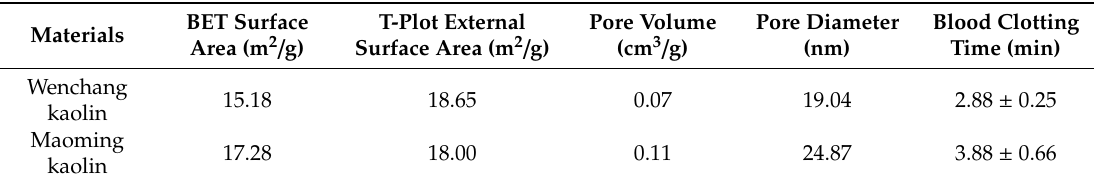
Table 2. Surface area characteristics calculated from nitrogen sorption isotherms and comparison with clotting times in whole blood of beagle dogs.